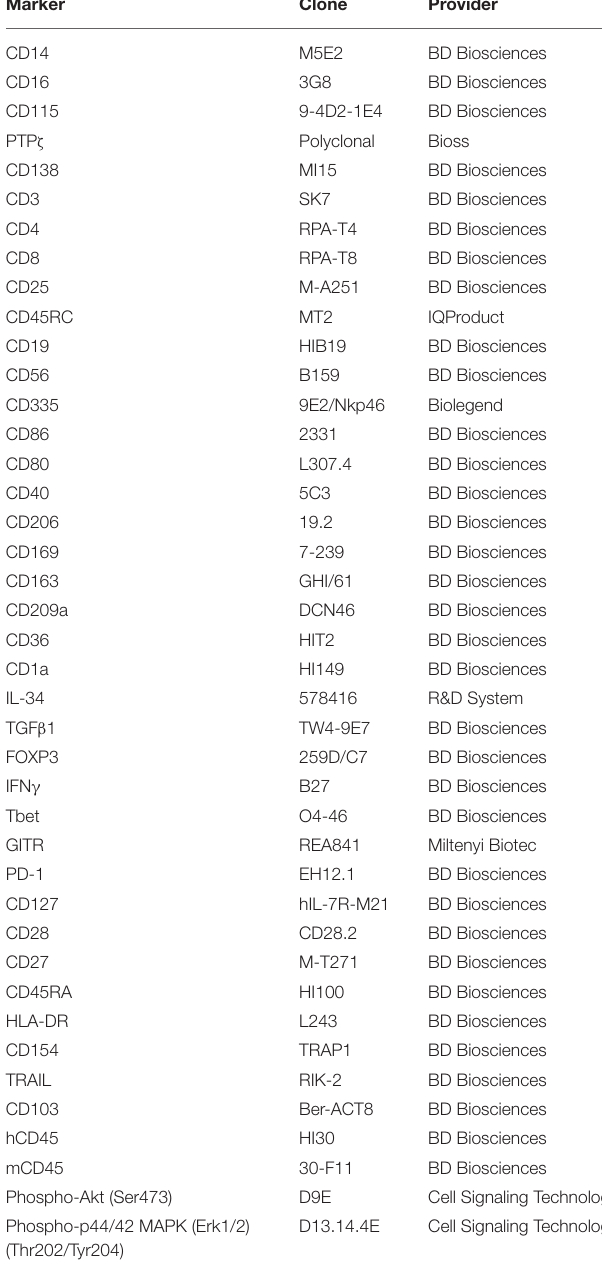
TABLE 1 | List of antibodies